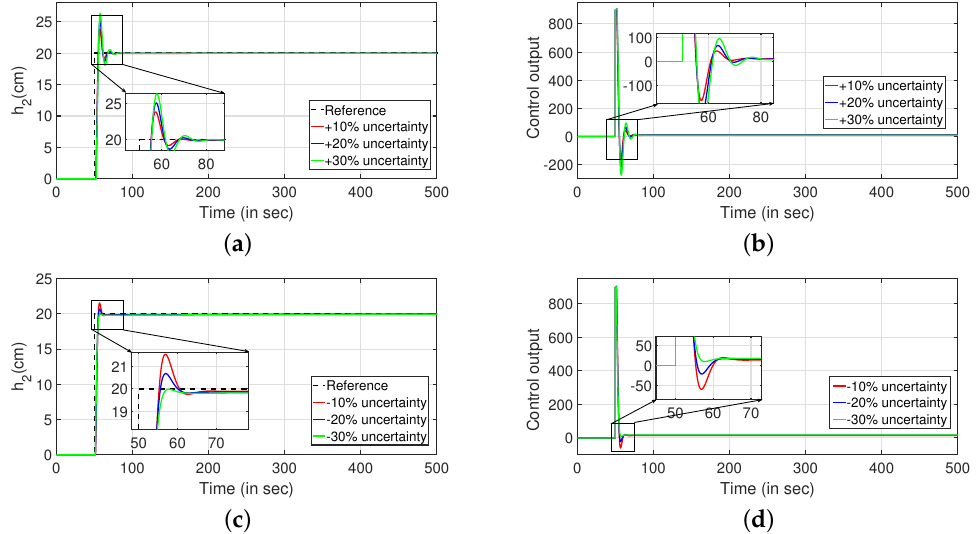
Figure 12. Reference tracking of Equation (38) for ± 10%, ± 20% and ± 30% uncertainties. ( a ) Level Variation in tank 2. ( b ) Control output. ( c ) Level Variation in tank 2. ( d ) Control